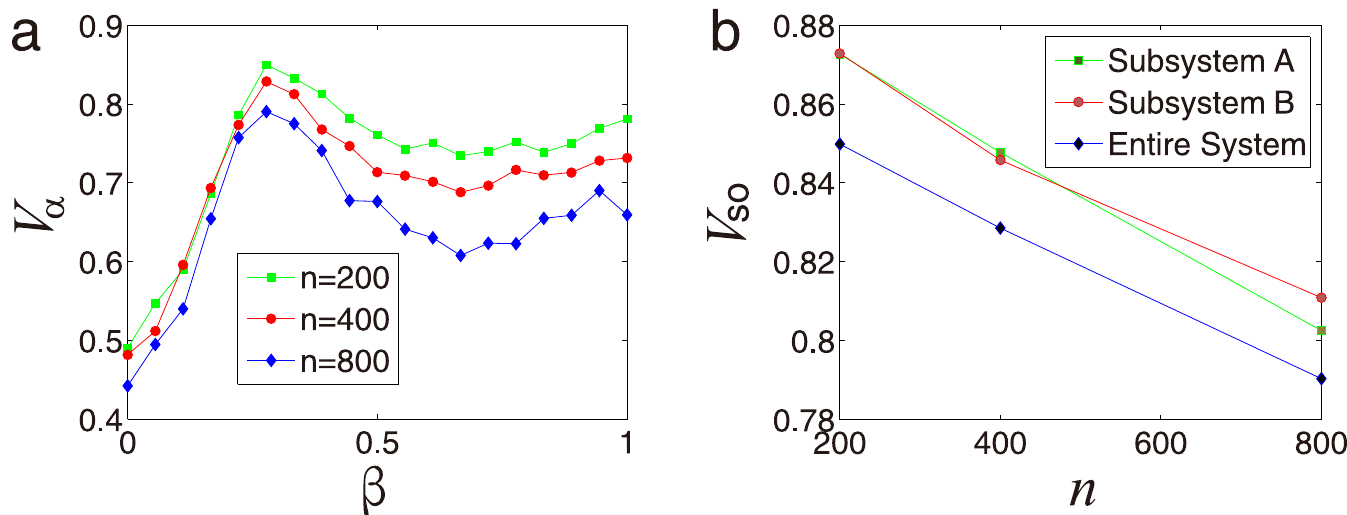
Fig 3. System size effect for SPA systems coupled by symbiotic relationship. (a) Synchronization V α as a function of the coupling strength β under different system size n of two subsystems, exhibiting that there exists an optimal value of β , when β = β o the the entire system reaches an optimal synchronization. (b) Optimal synchronization V so as a function of system size n for subsystem A, subsystem B and the entire system. All the data points are in S1 File.